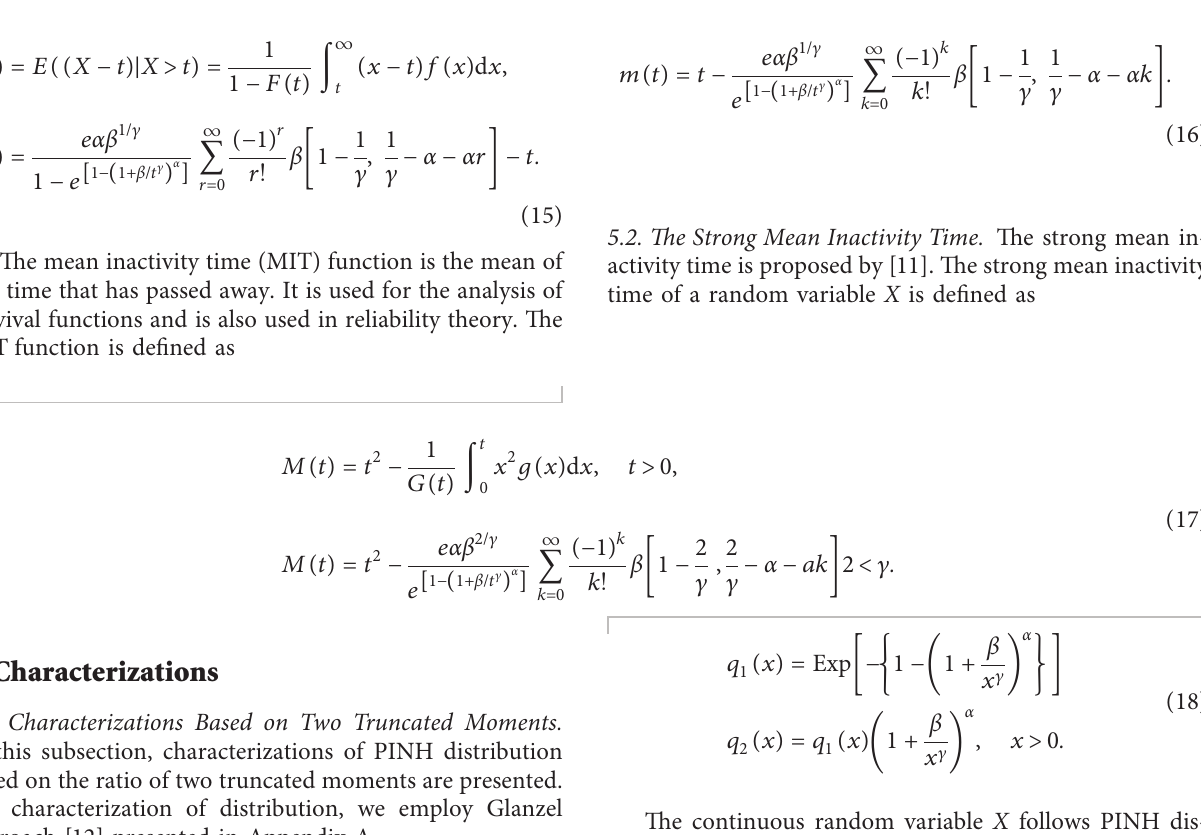
Figure 2: Hrf curves of PINH distribution for some parameter